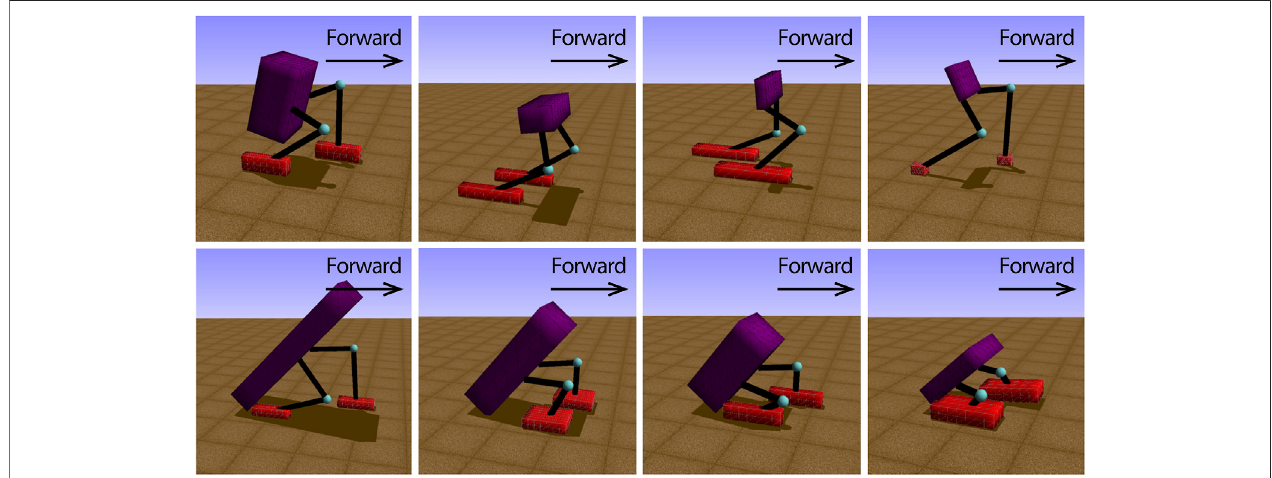
FIGURE 5 | Individuals of bipeds and tripods with different leg lengths, body sizes and foot sizes evolved in the simulation. At the beginning of the generation, the lengthofthefootisverylarge,sothatthefoothasenoughcontactareawiththeground,whichbene fi tstheindividualtomaintainstability.Whentheindividualreachesthe optimal bipedal gait (the upper right fi gure) , the short feet are more conducive to the swing of its legs and obtain faster forward speed. The upper fi gure of individuals are all bipedalism, and the lower fi gure of individuals perform supported tripod walking gaits.